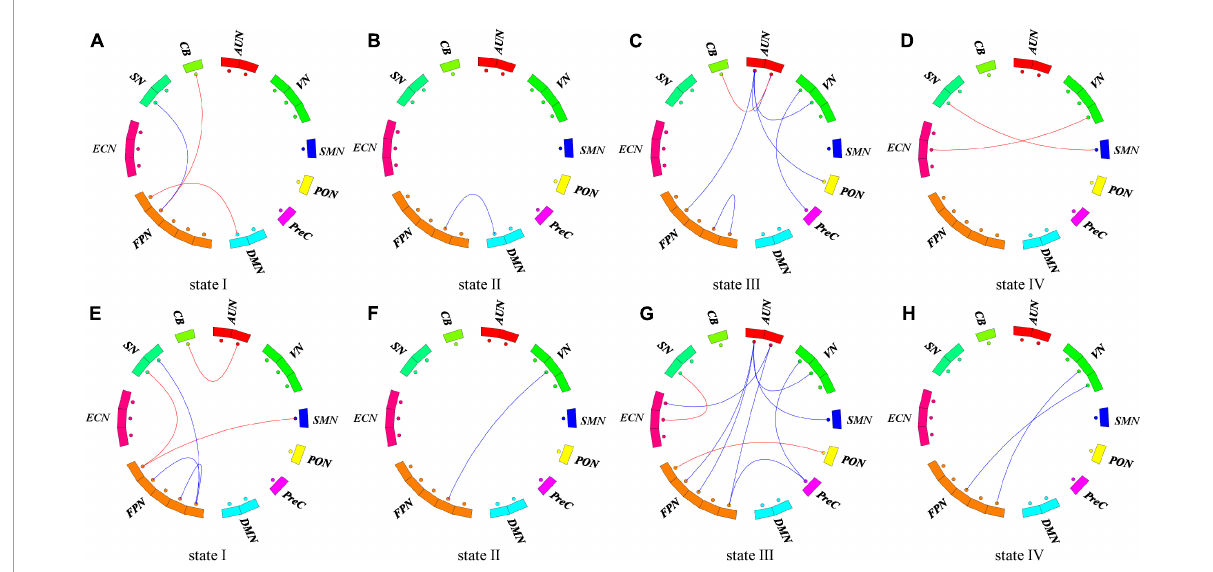
FIGURE6 Functional connectivity differences in each state. (A–D) The difference of functional connection between hPSCI and HC groups in each state. (E–H) The difference of functional connection between iPSCI and HC groups in each state. P < 0.01, uncorrected. The red lines represent stronger functional connectivity than the HC group. The blue lines represent weaker functional connectivity than the HC